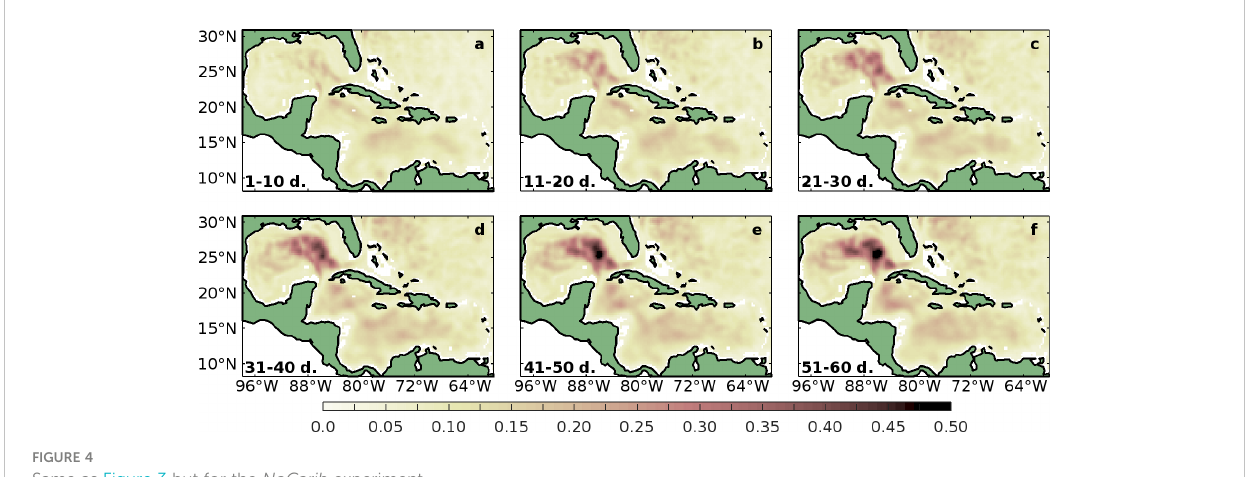
FIGURE 4 Same as Figure 3 but for the NoCarib